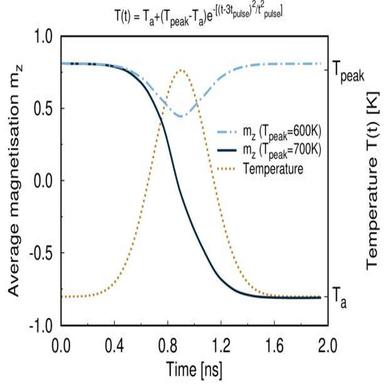
Time dependence of the average magnetisation for 100 FePt grains, obtained with the LLB solver, for a heat pulse with tpulse = 300 ps and Tpeak 600 K (dotand-dash blue) and 700 K (solid black) under an applied field of −1 T along the z–direction. The brown dotted line shows the time dependence of the temperature pulse.